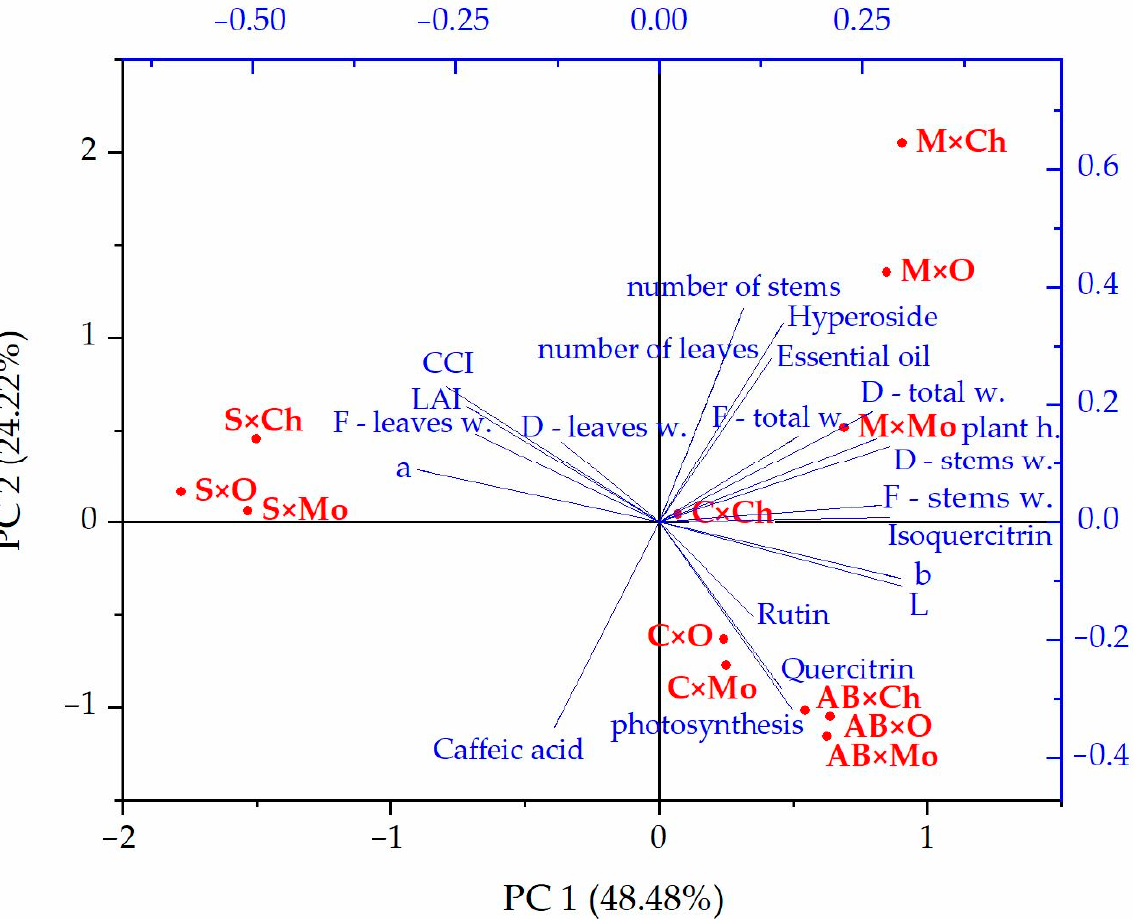
Figure 2. The 2D principal subspace for different cultivars of basil and fertilization treatments. With red color are the experimental factors (Cultivar × Fertilization type), and with blue color are the parameters and bioactive compounds analyzed at sweet basil